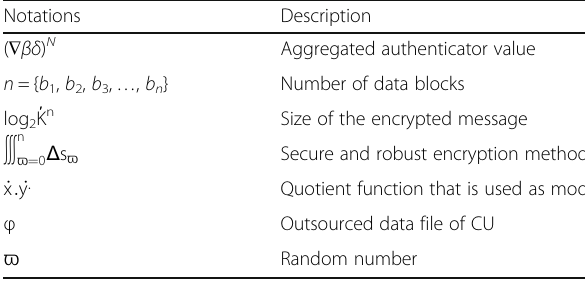
Table 3 System Parameters and Definitions of CU module